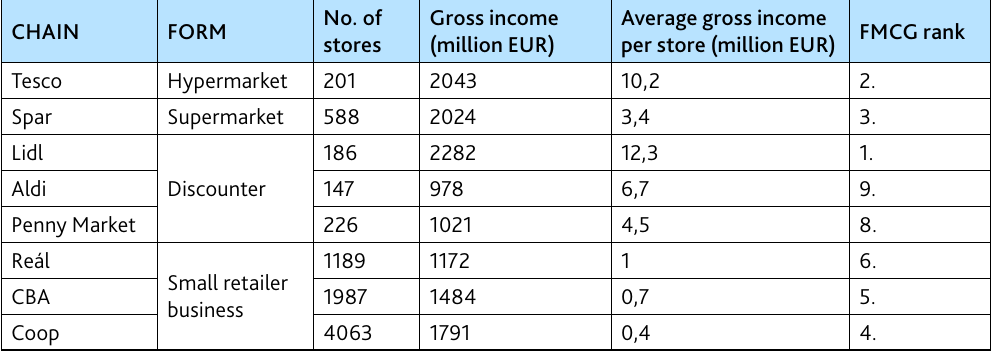
Table 1. The most important features of food supply chains in FMCG sector, 2020